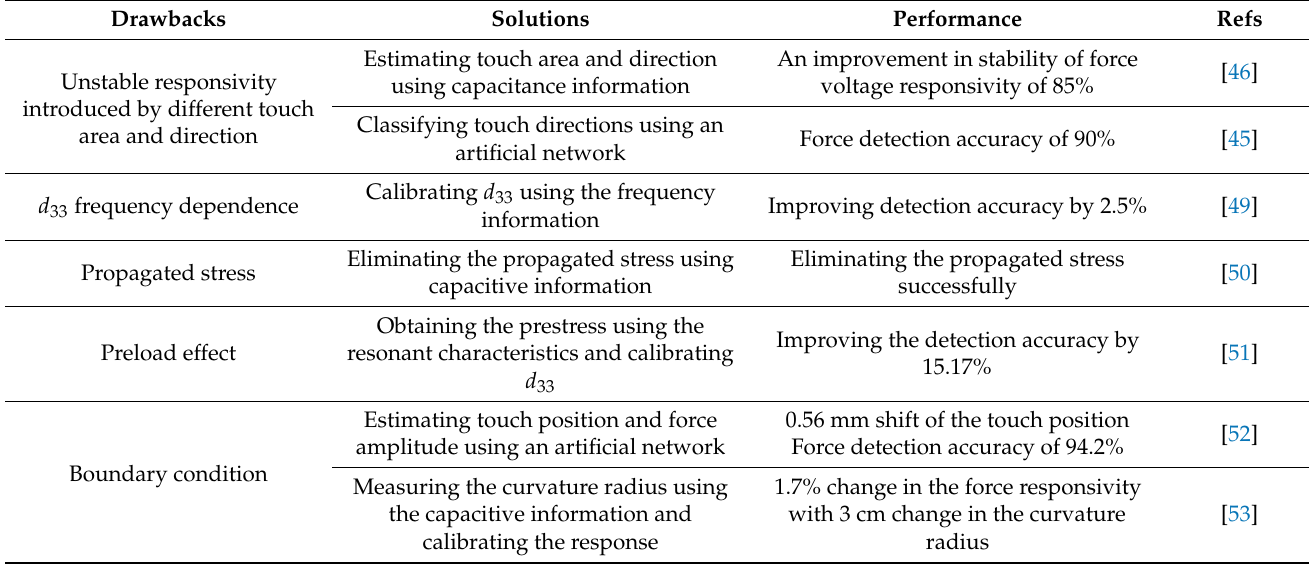
Table 3. Drawbacks of the piezoelectric touch panels and the state-of-art solutions.